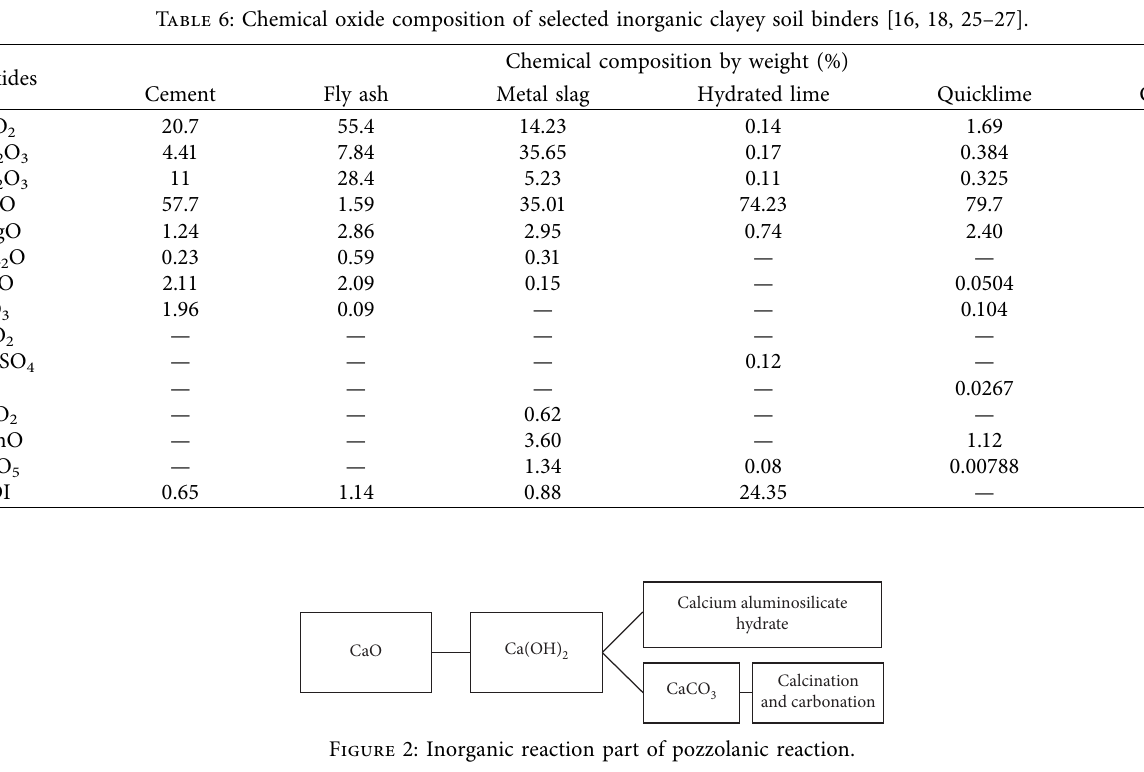
Table 5: Clayey soils degree of expansion related to swelling potential ( w